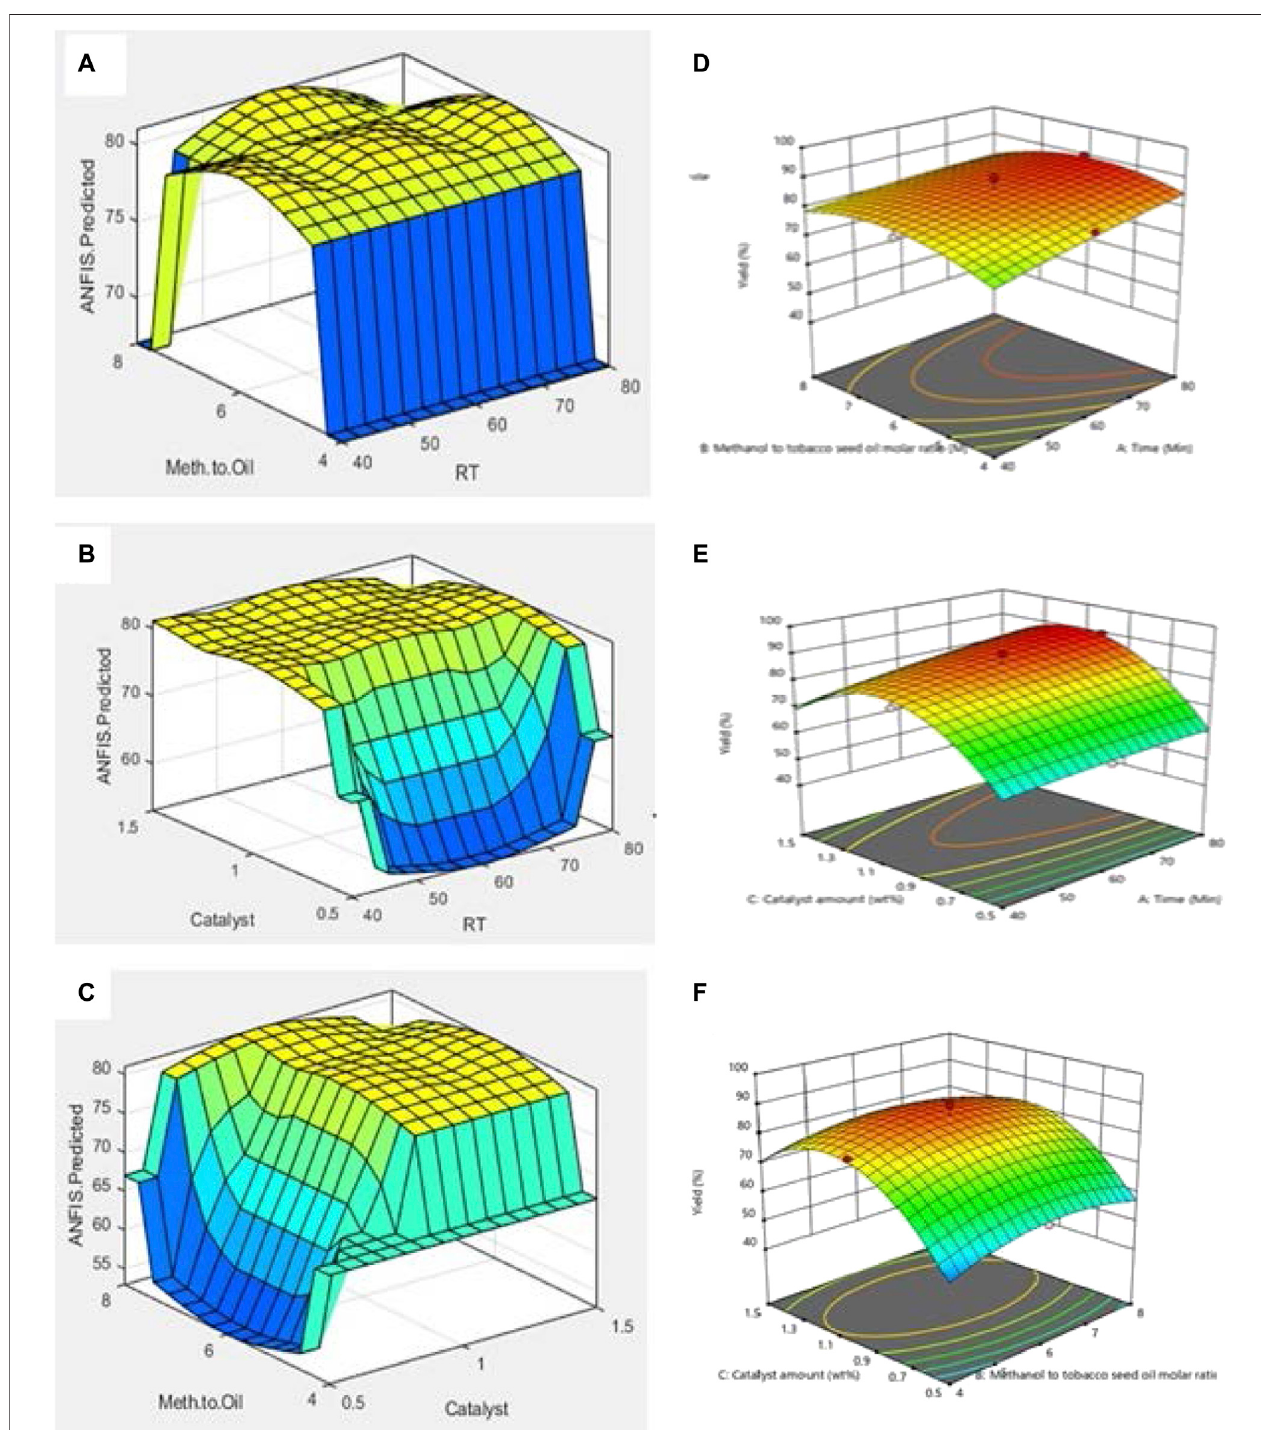
FIGURE 14 | 3D plots by (A – C) ANFIS and (D – F) RSM.